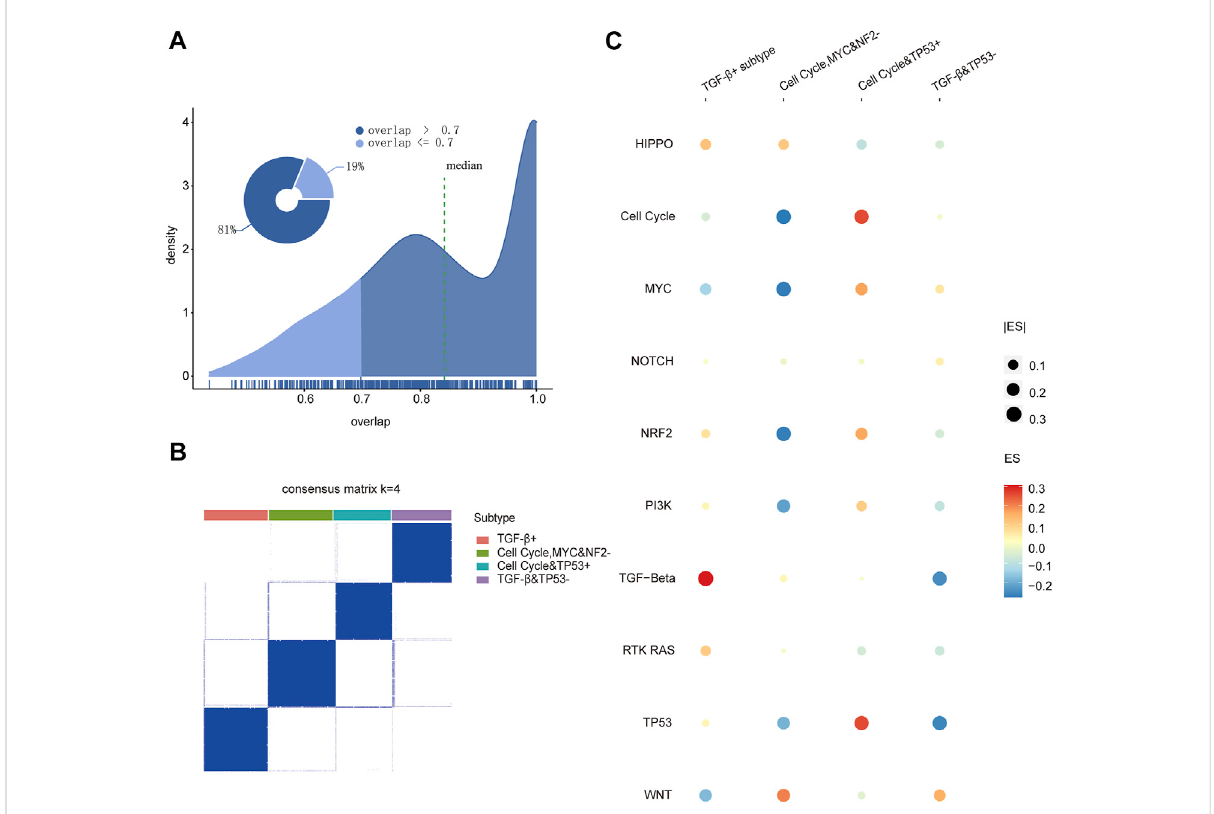
FIGURE 1 (A) Coincidence rate of the clustering results under different clustering methods and measures. (B) Consistent clustering result by the kmdist- Spearman method to cluster the TCGA training set into four classes. (C) Dot plot of the enrichment scores for 10 pathways in four